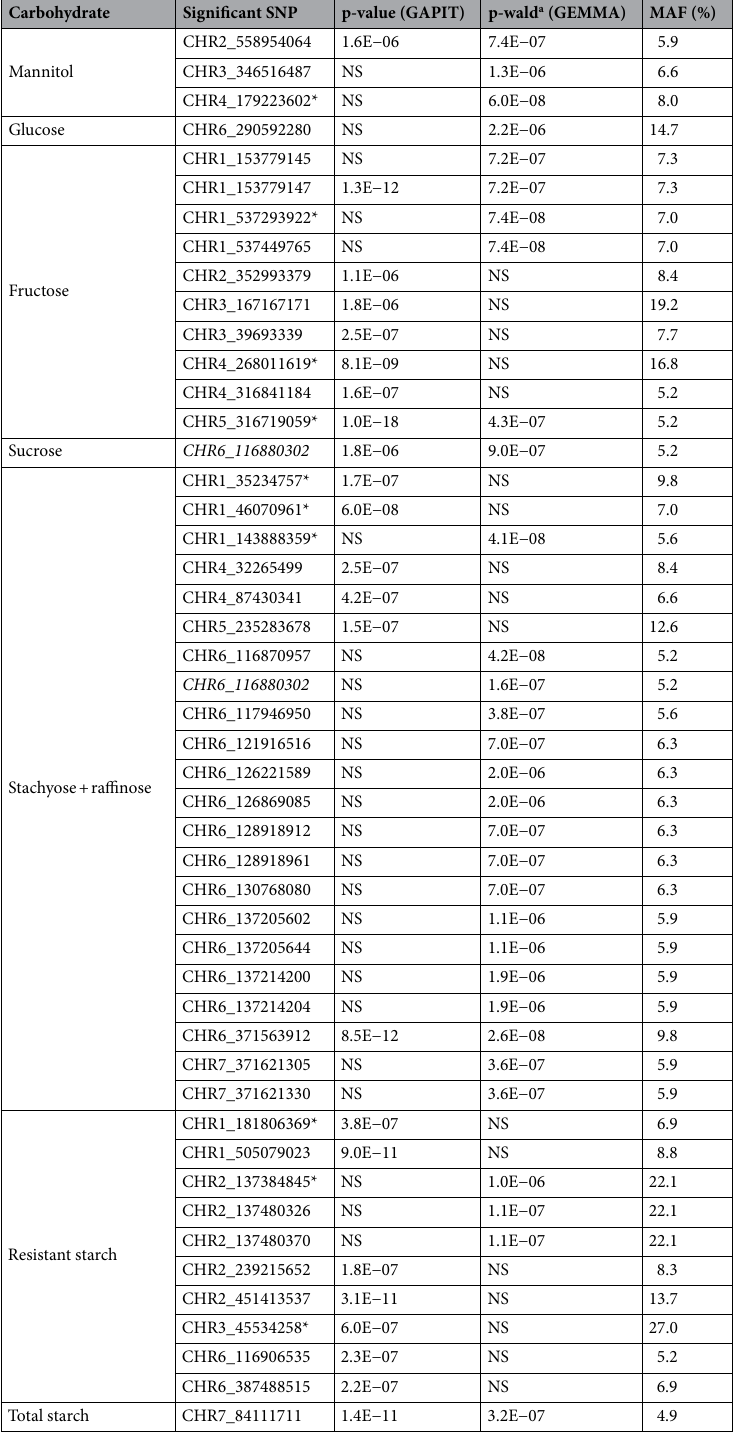
Table 3. Significant SNPs identified using GAPIT and GEMMA software. *Located within a gene. Italicized SNP ( CHR6_116880302) is associated with both suc and sta + raf. NS = not identified as significant by the software. a GEMMA p-wald values were from the Wald